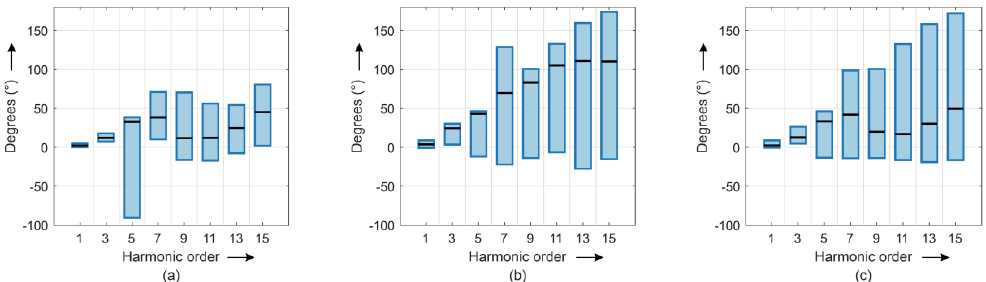
Figure 4. Difference in phase angle between flat-top and sinusoidal supply voltage: ( a ) Compact Fluorescent Lamps (CFL); ( b ) Light Emitting Diode (LED) lamps; ( c ) mix.